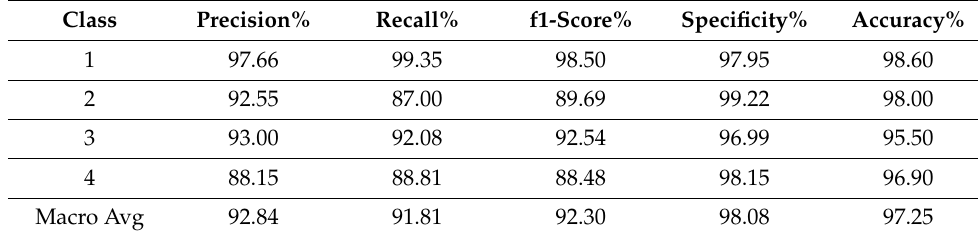
Table 1. Class-wise performance of APTOS